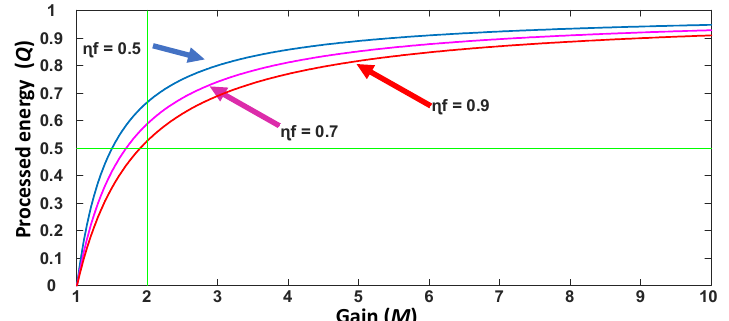
Figure 5. Behavior of processed energy with respect to gain.